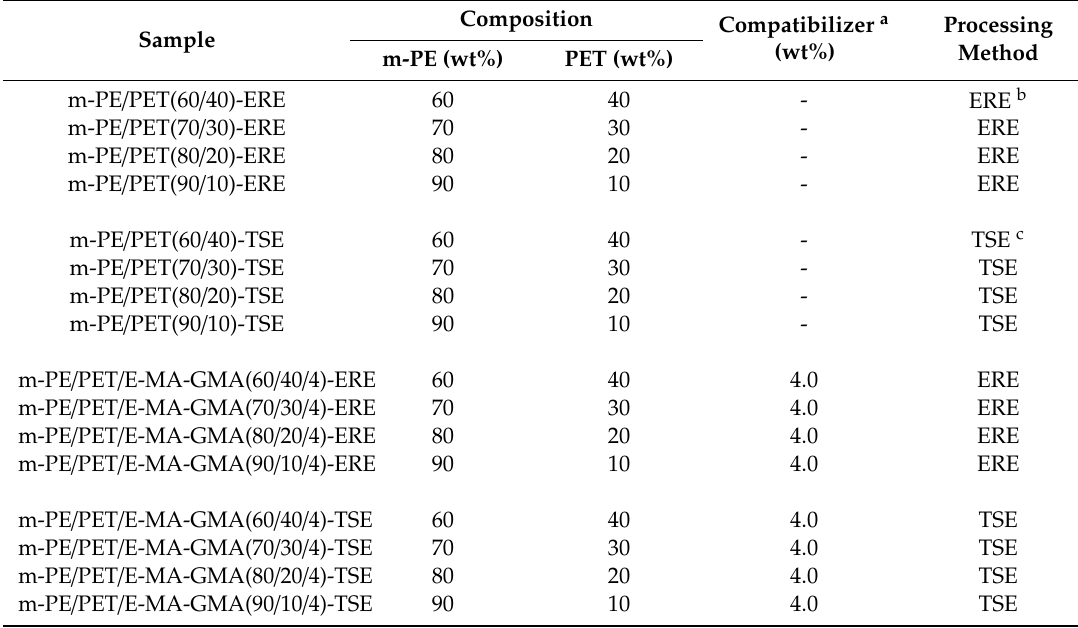
Table 1. Sample information of the fabricated metallocene polyethylene / poly(ethylene terephthalate) (m-PE / PET) blends in this